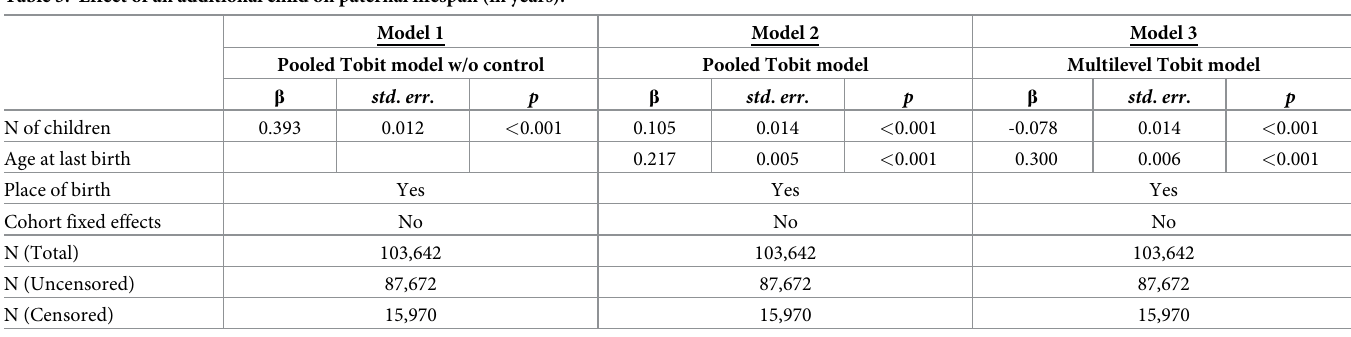
Table 3. Effect of an additional child on paternal lifespan (in years).